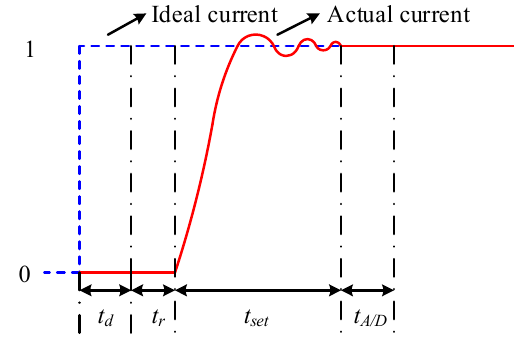
Figure 7. Ideal and actual current values in the turning on process.